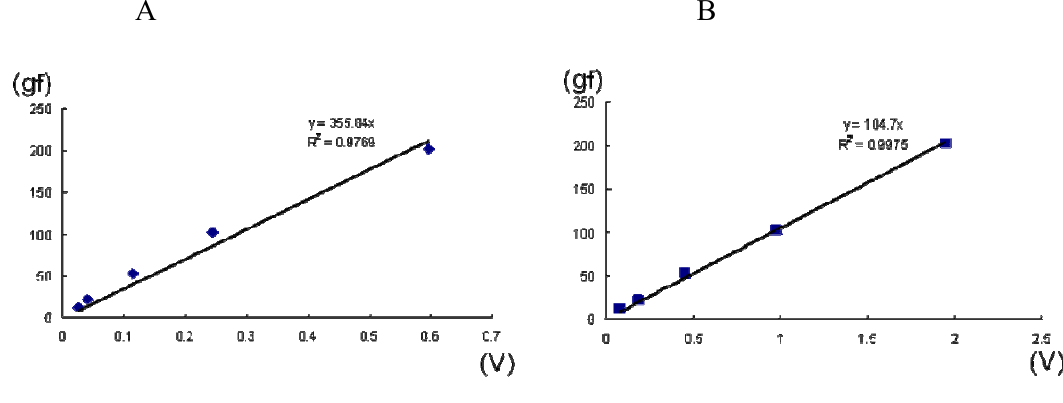
Figure 6. Comparison of the two types of apparatus that Masuda et al. , developed. A, B: Calibration lines for the measurement of multidirectional lip-closing force for devices using air-pressure sensors and strain gauges, respectively. The output of each apparatus is represented by voltage (V) in the abscissa and force (gram-force (gf)) in the ordinate. C: Radar chart of the impulses of lip-closing force in one subject. The blue and pink lines indicate multidirectional lip closing, as measured by devices using air pressure sensors and strain gauges,